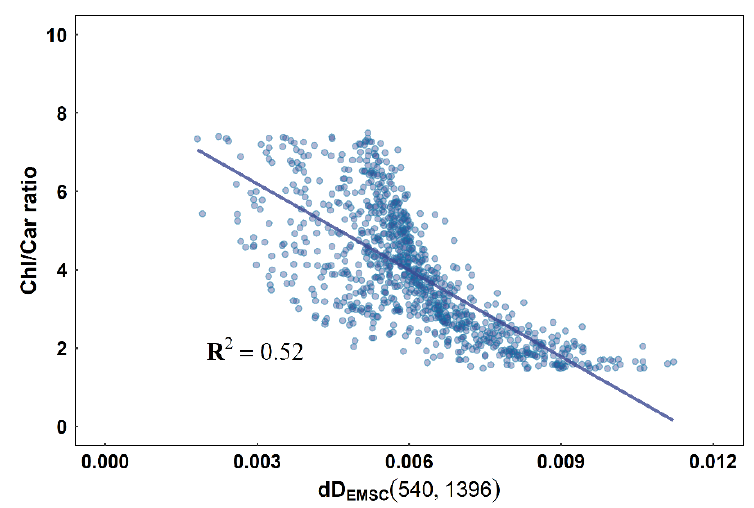
Figure 5. The relationship between dD EMSC (540, 1396) and Chl/Car ratio for a simulated dataset from PROSPECT 5. from PROSPECT